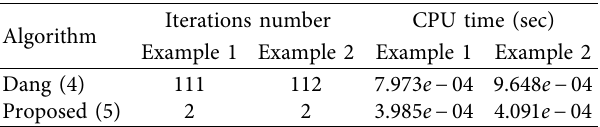
Table 1: Iteration steps and CPU time of the Dang method (4) and proposed method (5) for the numerical experiment of Examples 1 and 2.